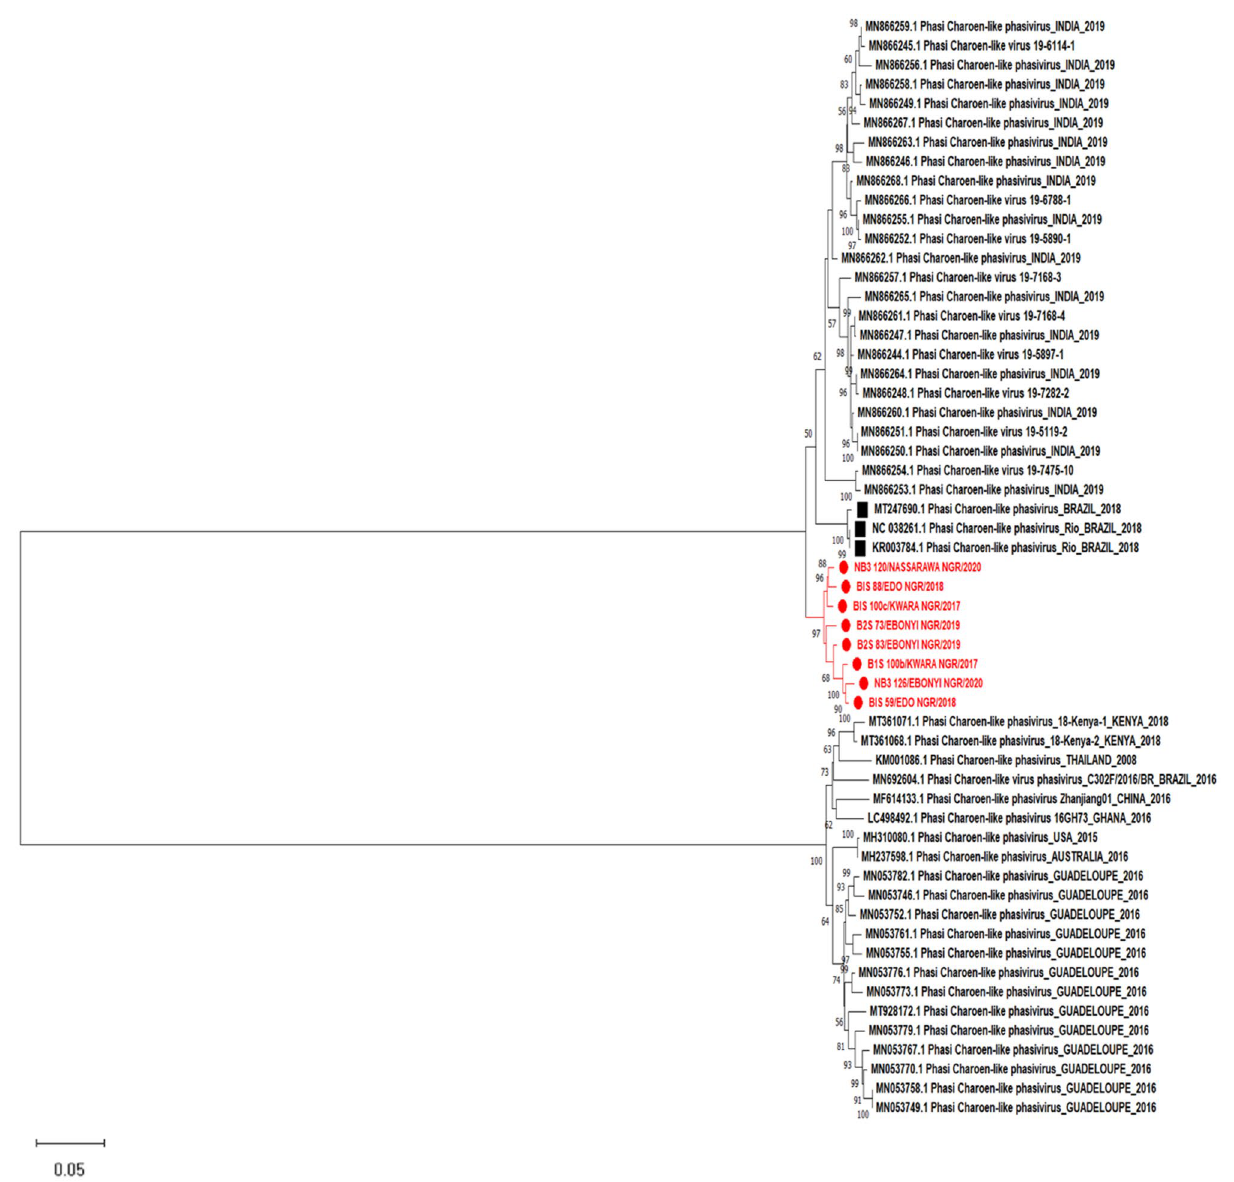
Figure 4. Maximum likelihood phylogenetic tree showing evolutionary relationship between the M segment (glycoprotein) of Phasi Charoen like phasivirus sequences from this study and those obtained from the NCBI database. The evolutionary history was inferred using the Maximum Likelihood method and Tamura-Nei model with 1000 bootstrap replicates. The numbers at branch nodes indicate the bootstrap values ≥